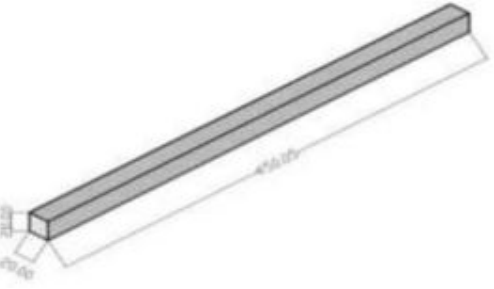
Figure 22. Dimensions of the bending specimen (Author’s own,